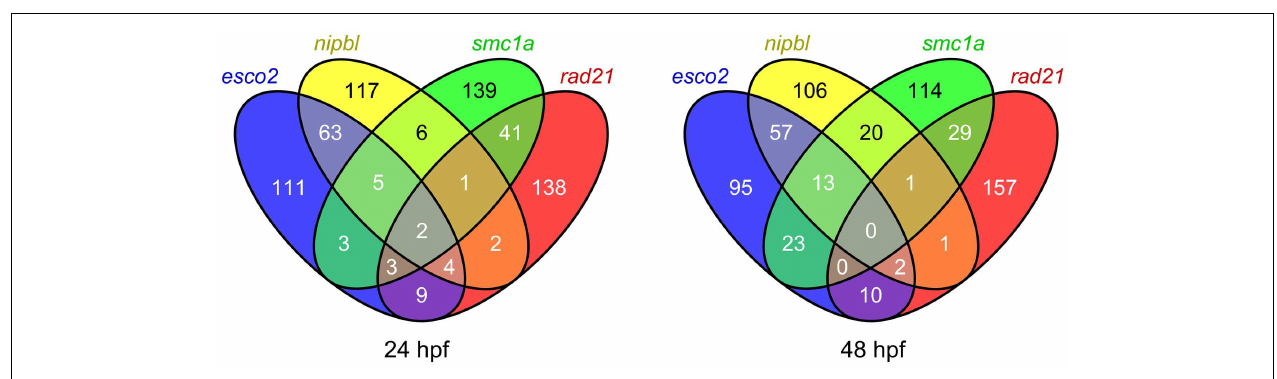
FIGURE 2 | Comparison of the top 200 affected probe sets in zebrafish embryos depleted of different cohesin subunits. Venn diagrams showing the overlap of the top 200 probe sets affected in zebrafish esco2 and nipbl morphants, and smc1a hi1113a and rad21 nz171 mutants at 24 and 48hpf ( q value <